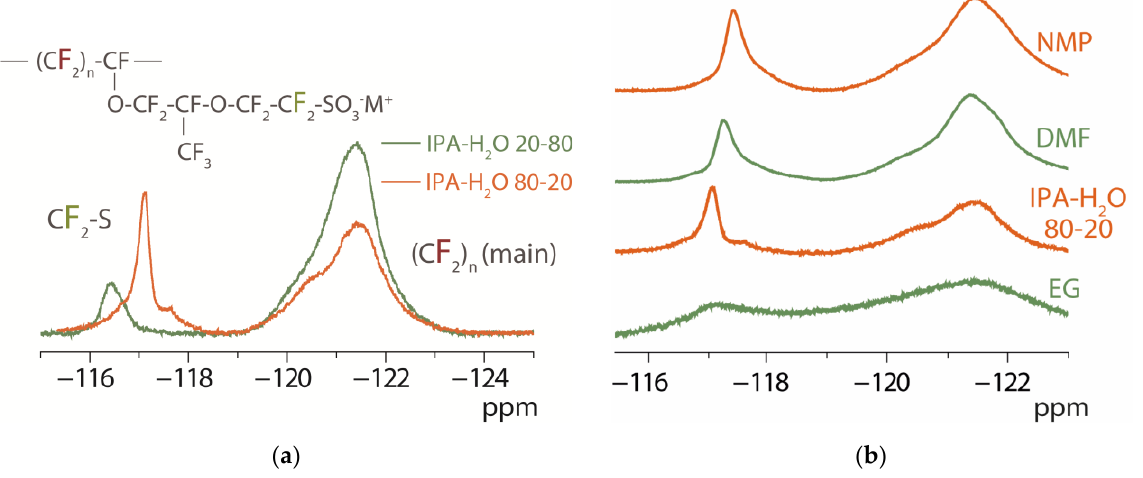
Figure 3. The fragments of 19 F NMR spectra of dispersions of Nafion in Li + -form (5 wt.%) in IPA-H 2 O mixtures in different ratios (a) and NMP, DMF, IPA-H 2 O 80-20, and EG (b) dispersing liquids.